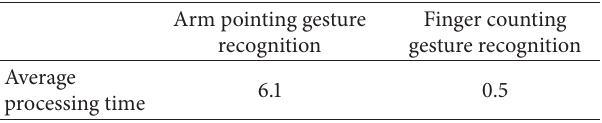
Table 3: Average processing times for arm pointing and finger counting gesture